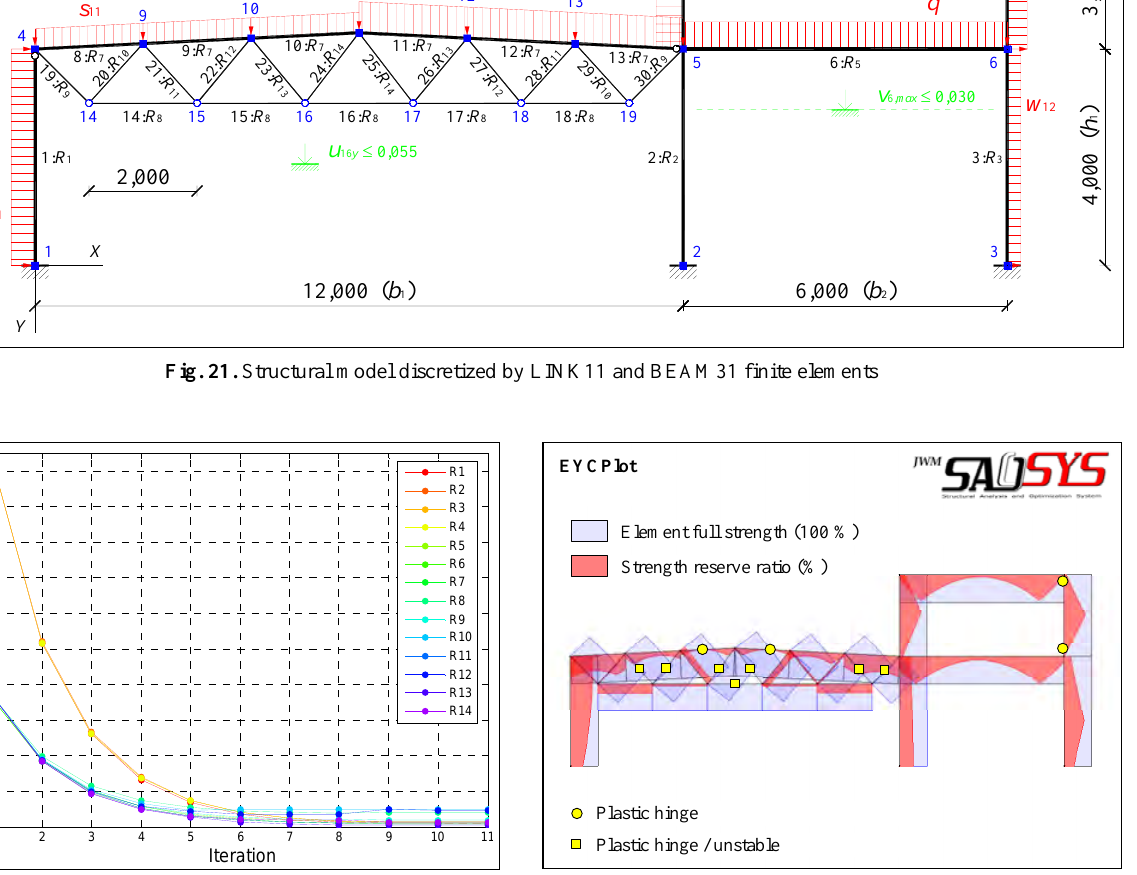
Fig. 22. Variation of G 0 in iterative calculations Fig. 23. The structure elements strength reserve diagram